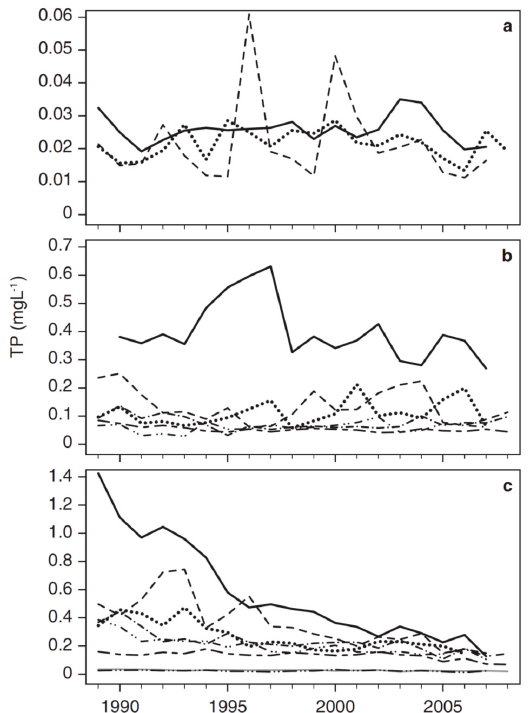
Figure 1. Annual mean total phosphorus (TP) change in lakes with no TP trend (N lakes, a ), with a weak decreasing TP trend (W lakes, b ) and with a strong TP decrease (S lakes, c ). Two lakes at the bottom of the c plot were not included in the S lake category due to very low TP concentrations. Note that the range of the y axes are different between the plots.